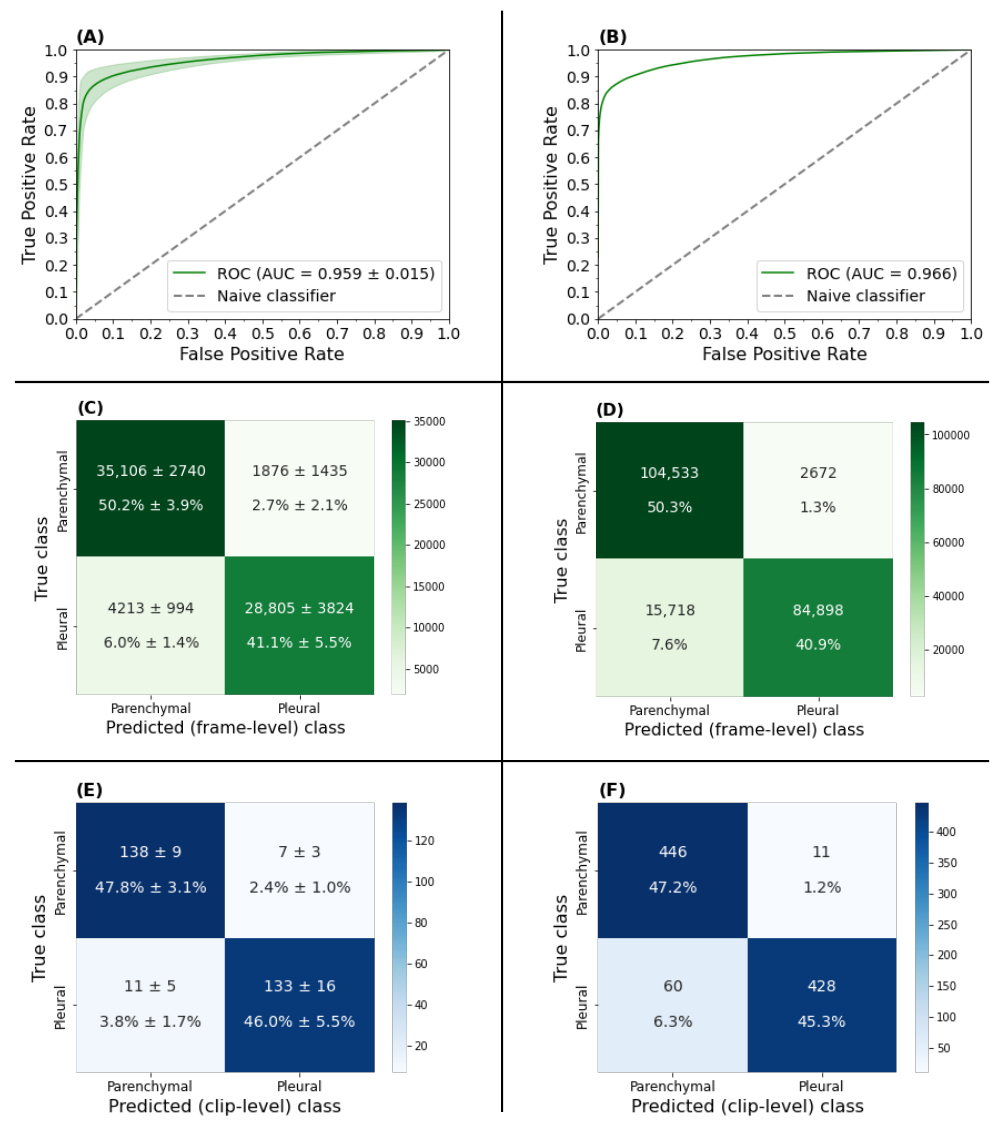
Figure 5. Receiver-operator characteristic curves with corresponding frame (green) and clip-based (blue) confusion matrices for the 10-fold cross validation experiment ( A , C , E ) and holdout set infer- ence ( B , D , F ). ( A ) AUC of the 10-fold cross validation experiment averaged 0.959 ( ± 0.015) with the corresponding frame and clip-based confusion matrix results in ( C ) and ( E ), respectively. ( B ) Inference on the holdout set yielded an AUC of 0.966 with the corresponding frame and clip-based confusion matrix results in ( D ) and ( F ),